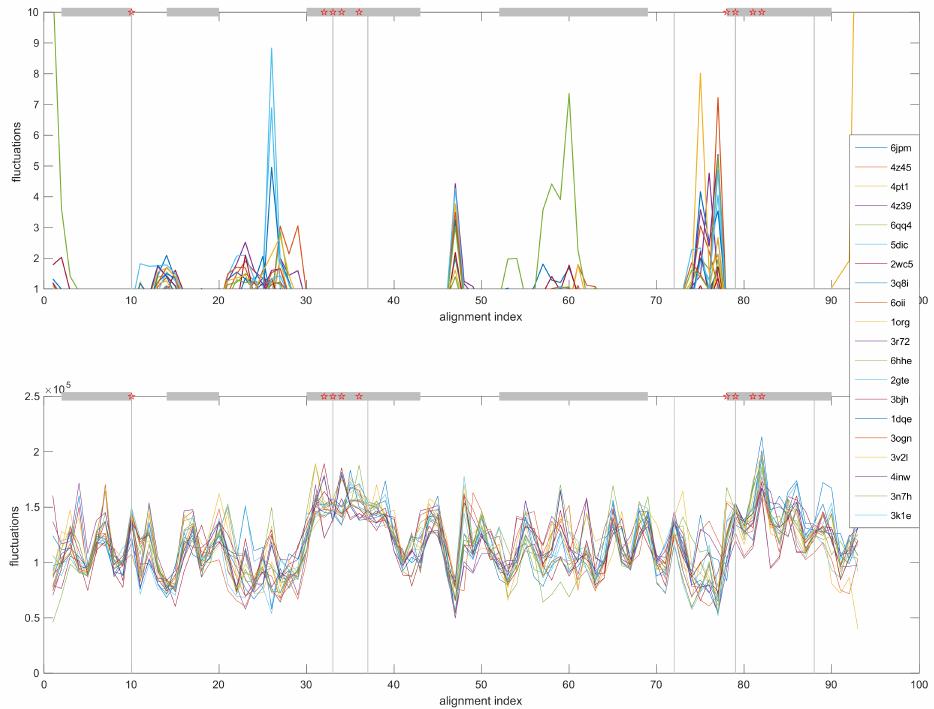
Figure 8. Calculated OBP residue square fluctuations and residue deformation energy profiles. The alignment index refers to columns with 100% occupancy. The horizontal bars in grey show helical regions. * Alignment index positions showing high enrichment in evolutionary coupling